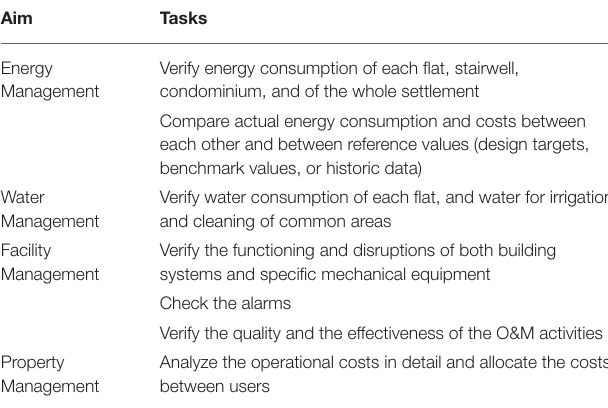
TABLE 3 | Example of tasks that can be performed through Enteliweb.